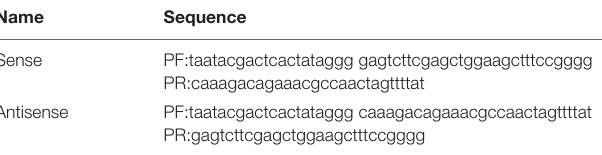
TABLE 4 | The effect of lncRNA TPA overexpression and knockdown on cell migration ( χ ± S, n = 3). Groups Cell migration rate (%) 24 h 48 h Normal breast cancer cells 8.00 ± 1.15 14.06 ± 0.65 lncRNA TPA overexpression